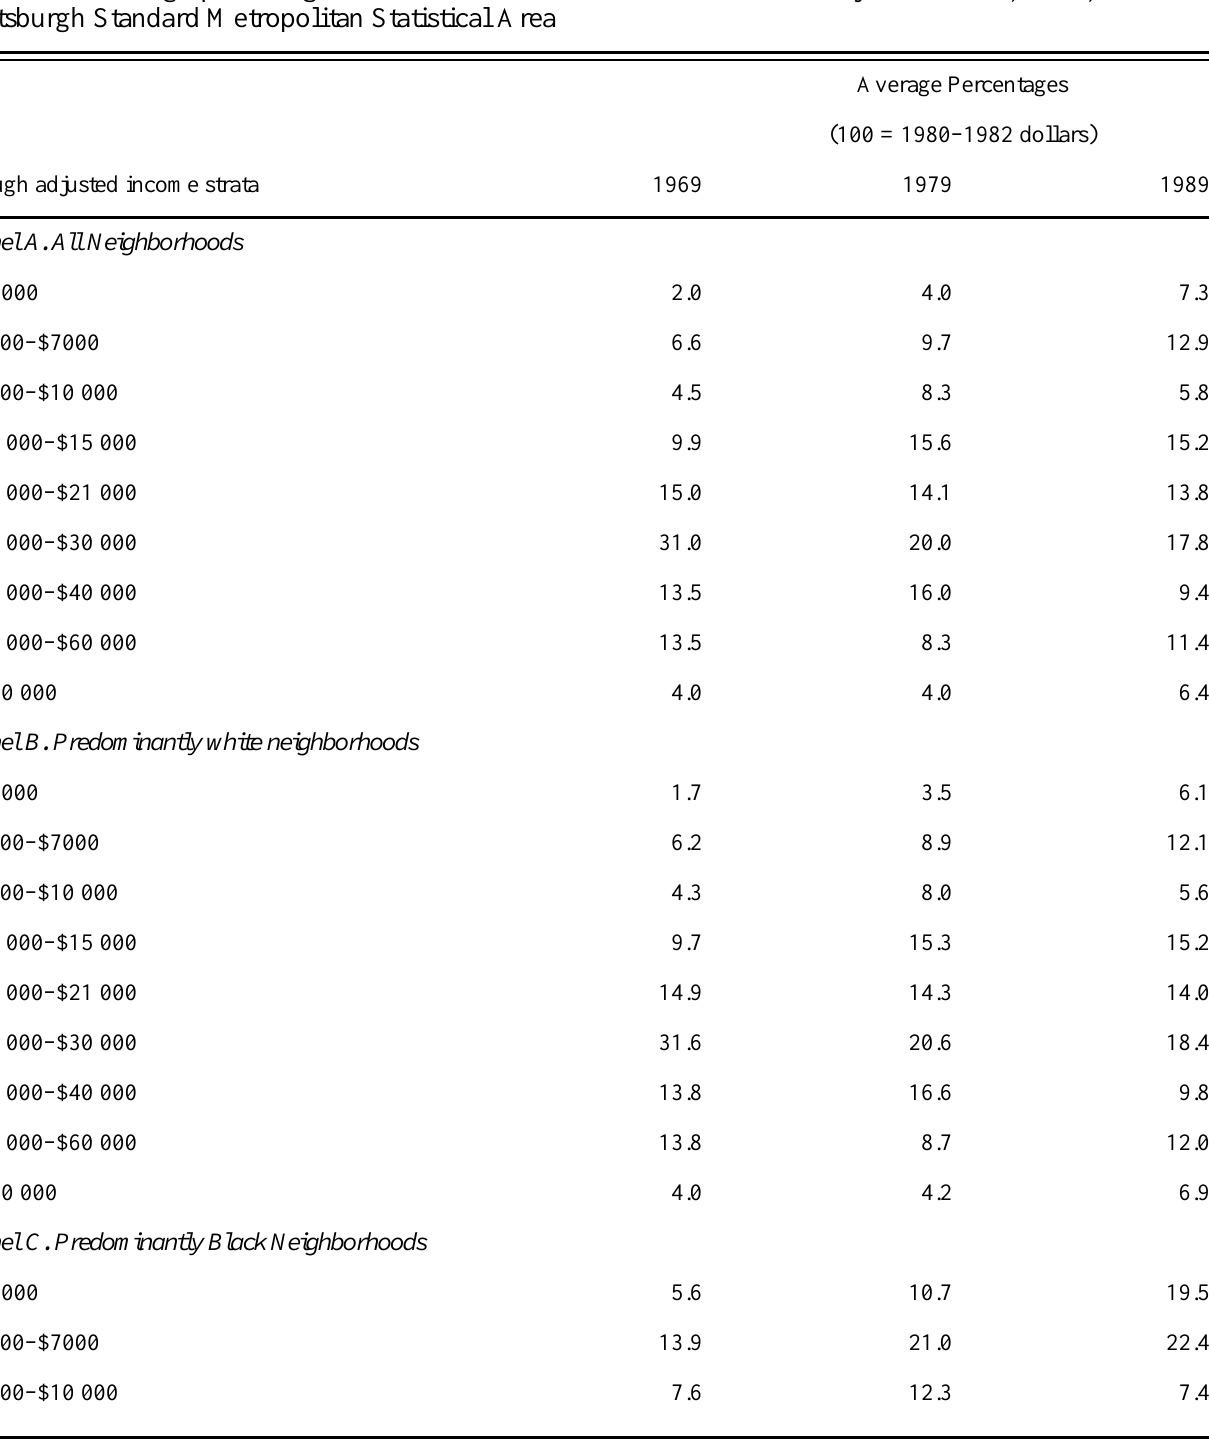
Average Percentages (100 = 1980–1982 dollars)